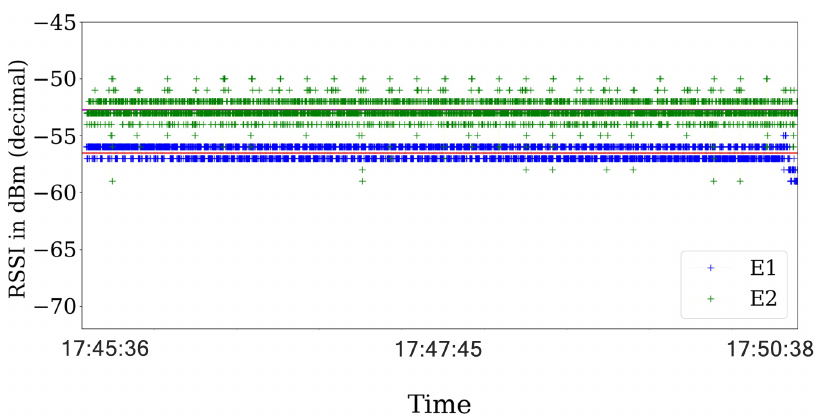
Figure 11. RSS value for the reactive strategy were the red and violet horizontal lines shows the average value across the experiment for each transmitter. The RSS values almost no present notable variations across the experiment.